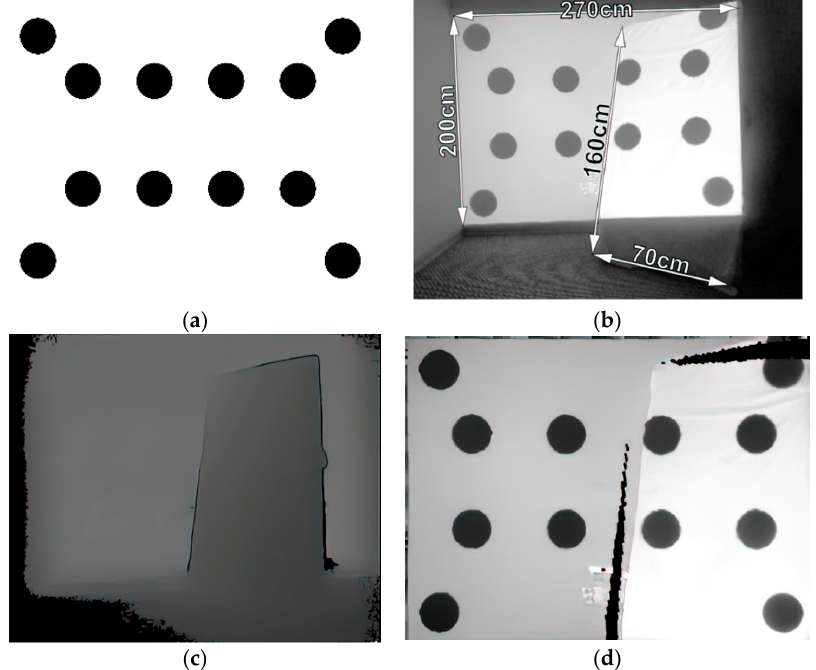
Figure 5. The calibration process ( a ) Image displayed from the projector, ( b ) RGB photo, ( c ) depth map, ( d ) photo obtained as a result of the 3D-to-2D transformation.